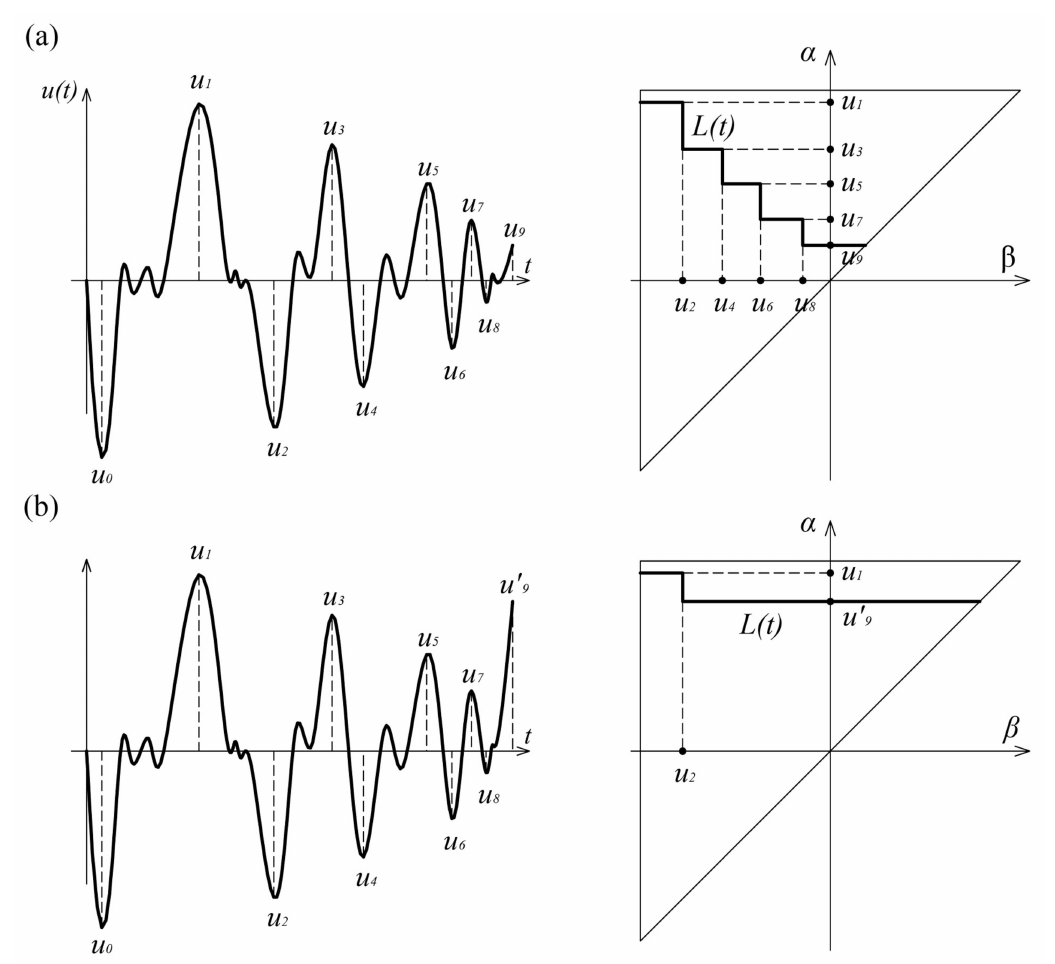
Figure 7. The wiping-out property of the Preisach model: ( a ) Load history u 1 –u 9 ; ( b ) Load history u 1 –u (cid:48) 9